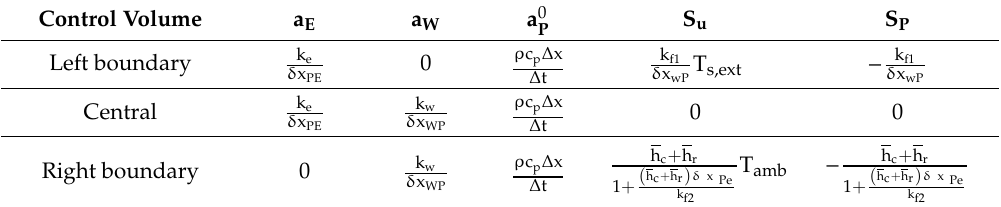
Table 2. Coe ffi cients of the discretized equation for each control